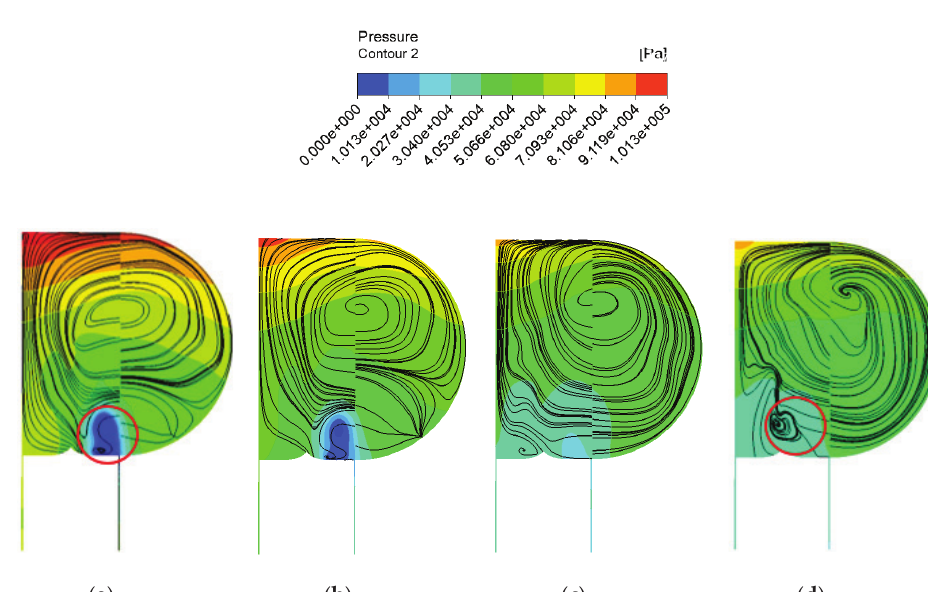
Figure 14. Pressure and velocity streamlines between impeller and side channel: ( a ) single phase, ( b ) IGVF 2%, ( c ) IGVF 4%, ( d ) IGVF